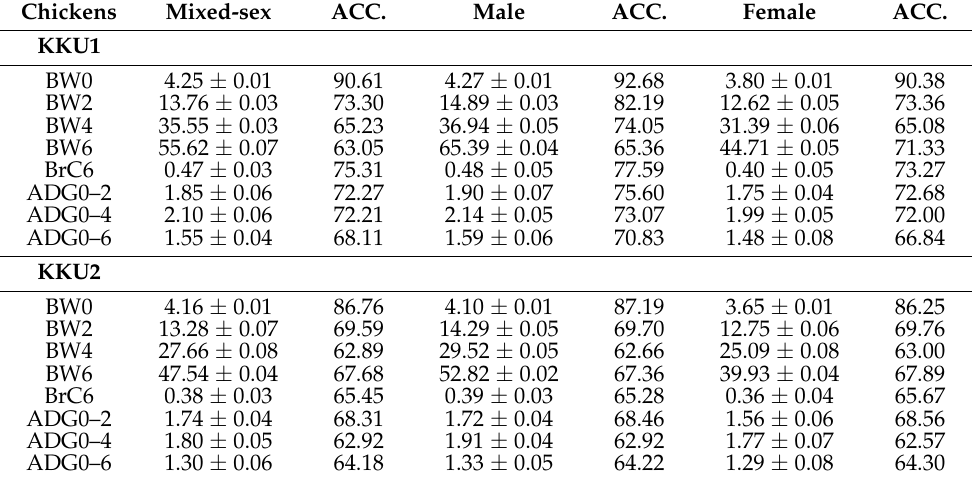
Table 5. Estimated breeding value ± standard error (S.E.), and accuracy of the estimated breeding value of the top 20% Thai indigenous synthetic chickens. Chickens Mixed-sex ACC. Male ACC. Female ACC. KKU1 BW0 4.25 ±